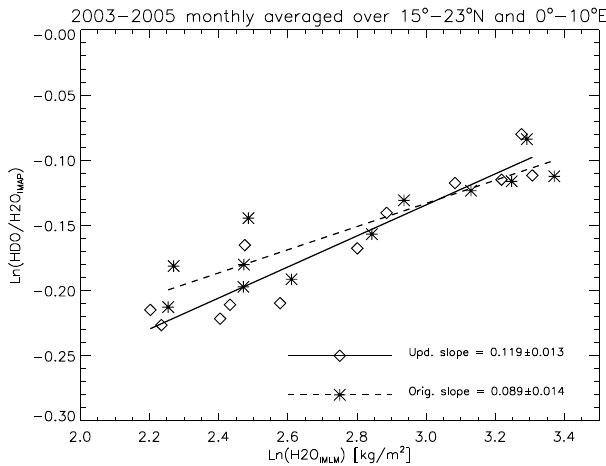
Fig. 12. Rayleigh-type plot for the region above the Sahel. Monthly averages were taken for the years 2003–2005. For the x-axis, H 2 O retrievals from the IMLM algorithm of Schrijver et al. (2009) were used and matched with our retrievals of the HDO/H 2 O ratio (y- axis). Comparing the original retrievals (stars and dashed line) with the updated retrievals (diamonds and solid line), we find that the updates lead to a steeper slope. The updated and original slope cor- respond to a fractionation temperature of 266 ± 7K and 285 ± 10K, respectively. For the updated retrievals the correlation coefficient increases from 0.90 to